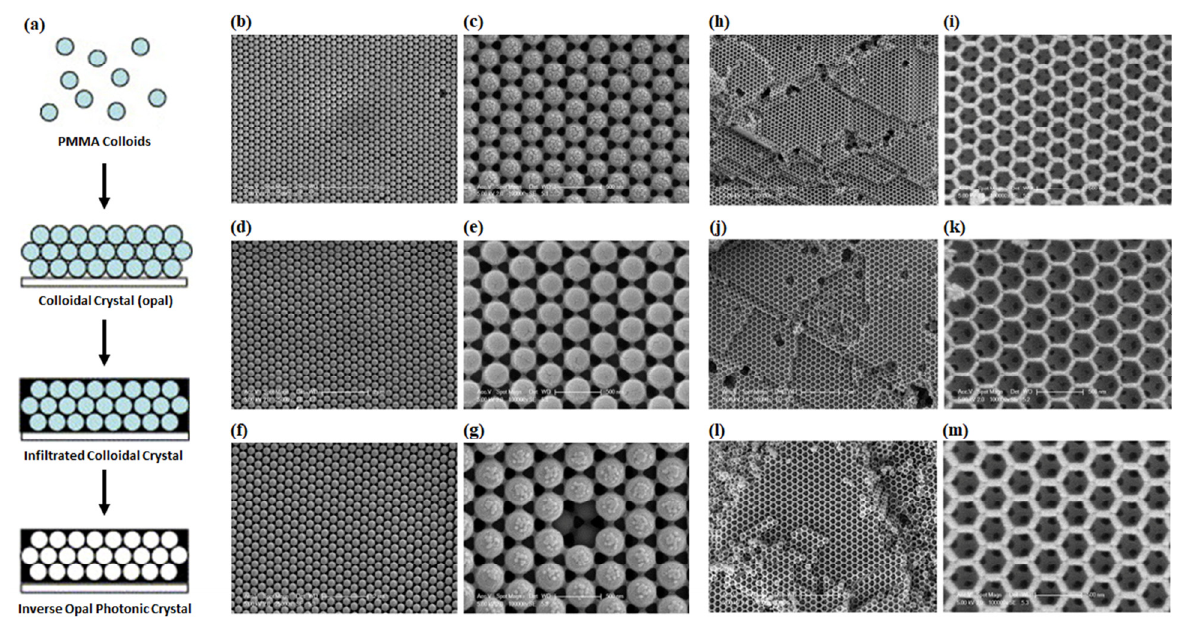
Figure 2. Overview of general fabrication strategy and structures of opal and inverse opal photonic crystals. ( a ) Schematic representation of the assembly process for fabrication of opal photonic crystals (OPCs) and inverse opal photonic crystals (IOPCs) from precursor PMMA colloidal microspheres. ( b – g ) SEM images of PMMA colloidal crystals fabricated using via flow-controlled vertical deposition. ( h – m ) SEM images showing SiO 2 inverse opals made from colloidal crystals templates shown in sub ‐ figures ( b – g ) ( left ). (Adapted with permission from [109]).